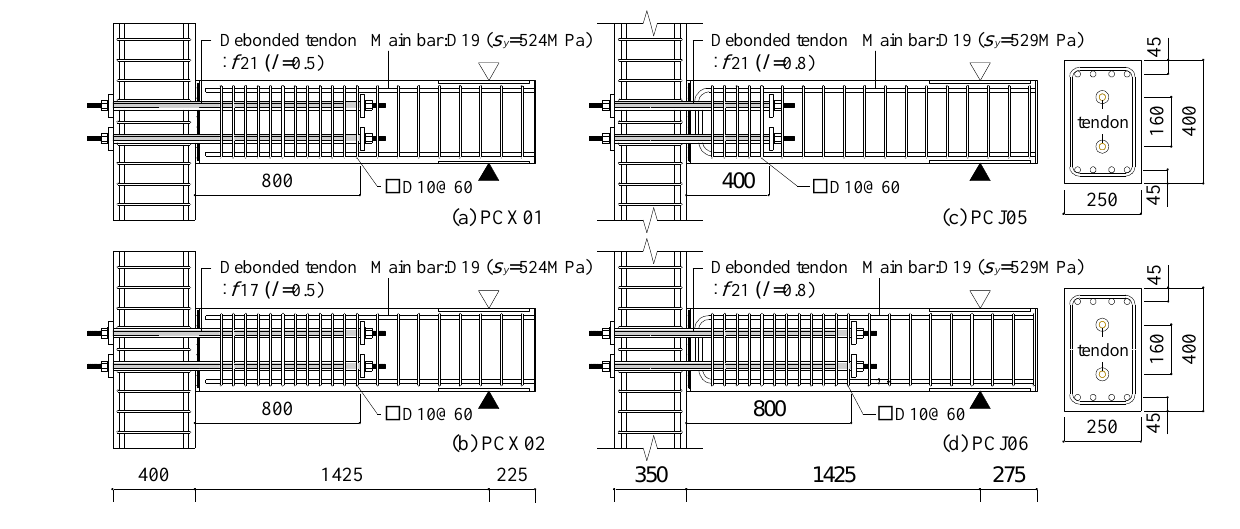
Figure 10. Specimen details (mm). Table 1. Specimen properties.